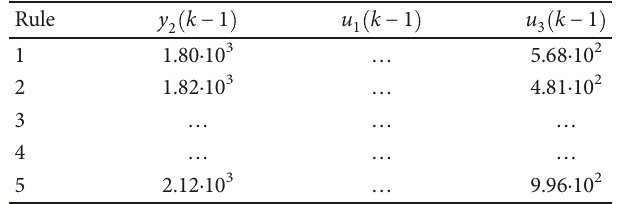
k = x k . Table 8: Cluster centers for biomass y 2